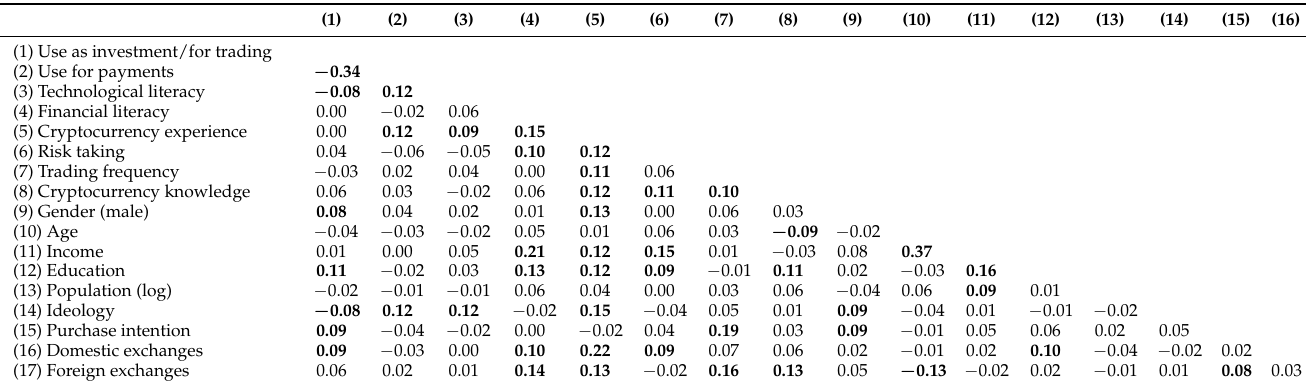
Table 1. Profiling Turkish cryptocurrency owners based on demographics and other factors.